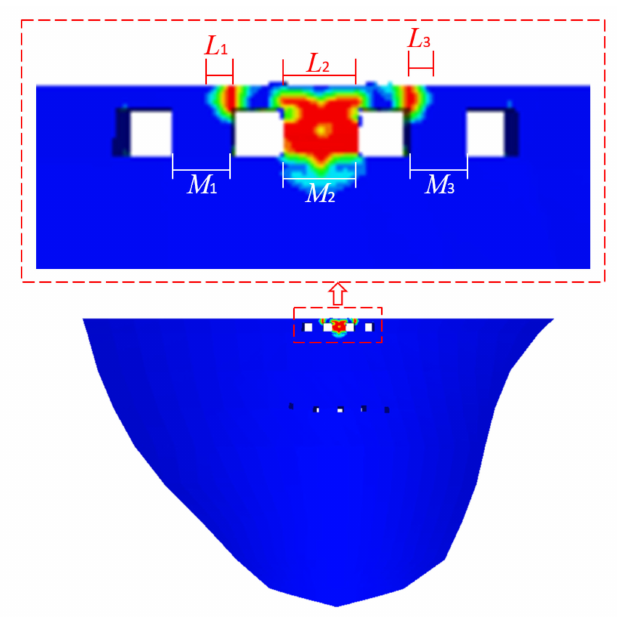
Figure 3. Parameters of local damage for the surface discharge